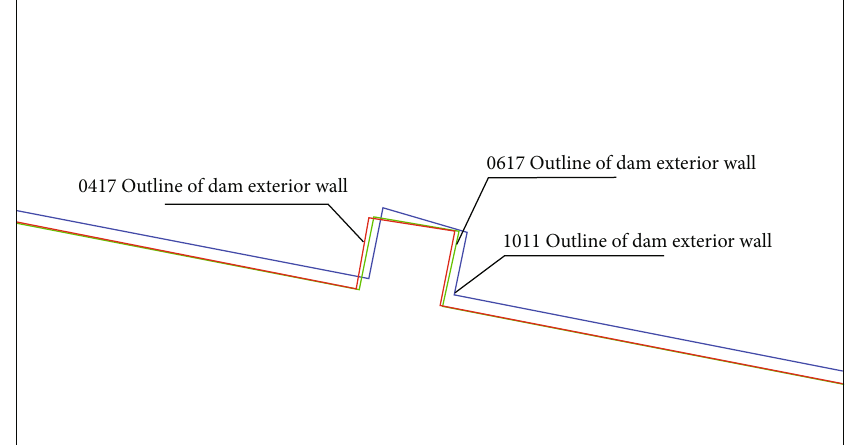
Figure 8: Deformation of the contour of the dam external wall.